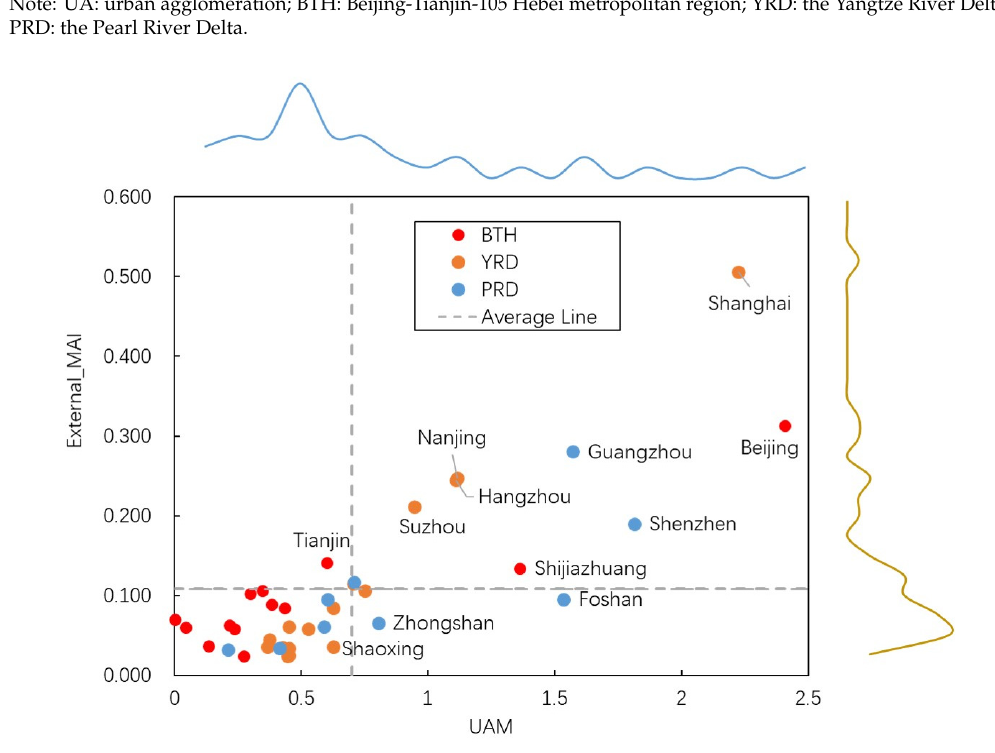
Figure 4. The scatter plot of external-MAI and UAM.